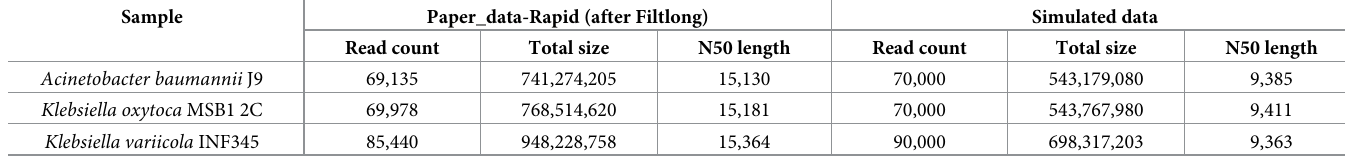
Table 1. The simulated data statistics of three bacterial strains.